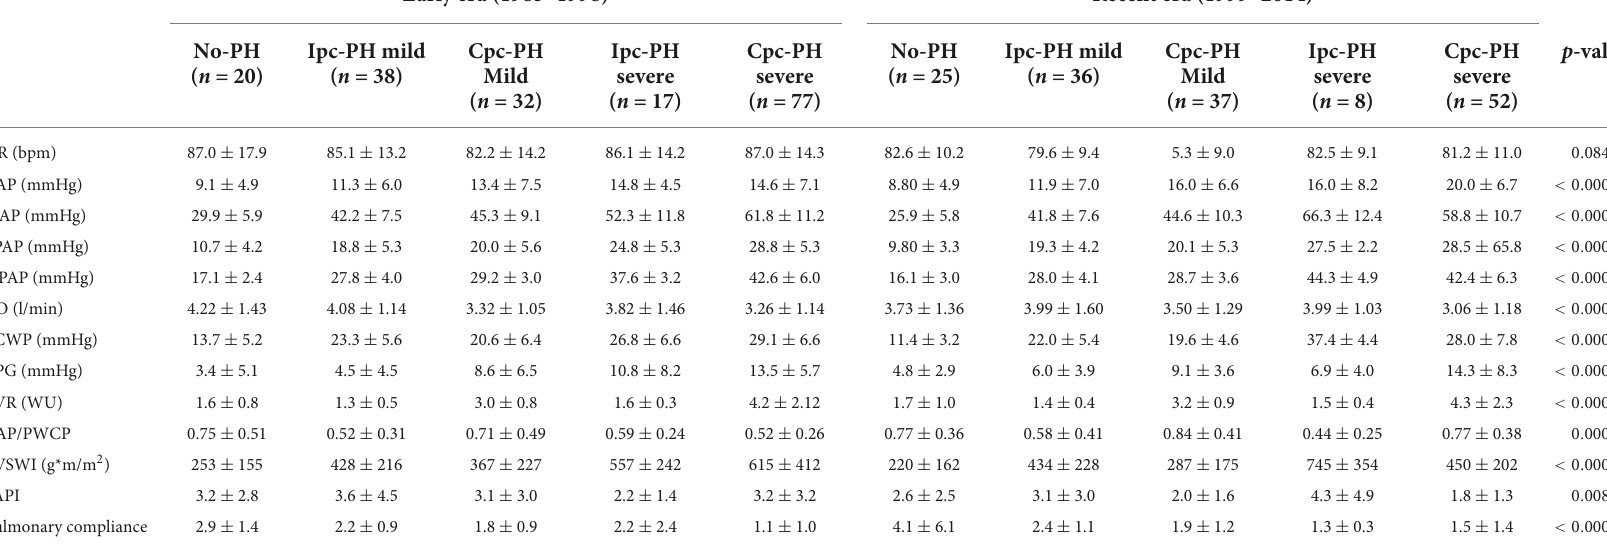
TABLE 2 Hemodynamic parameters in relationship with the type and the severity of pulmonary hypertension for the early and recent